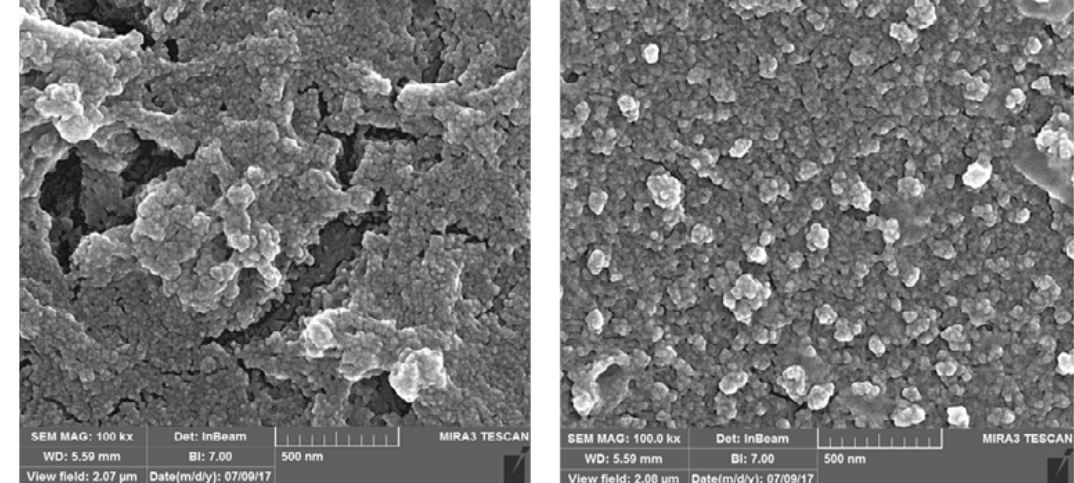
Fig. 3. SEM images of palladium oxide Fig 3. SEM images of palladium oxide nanoparticles